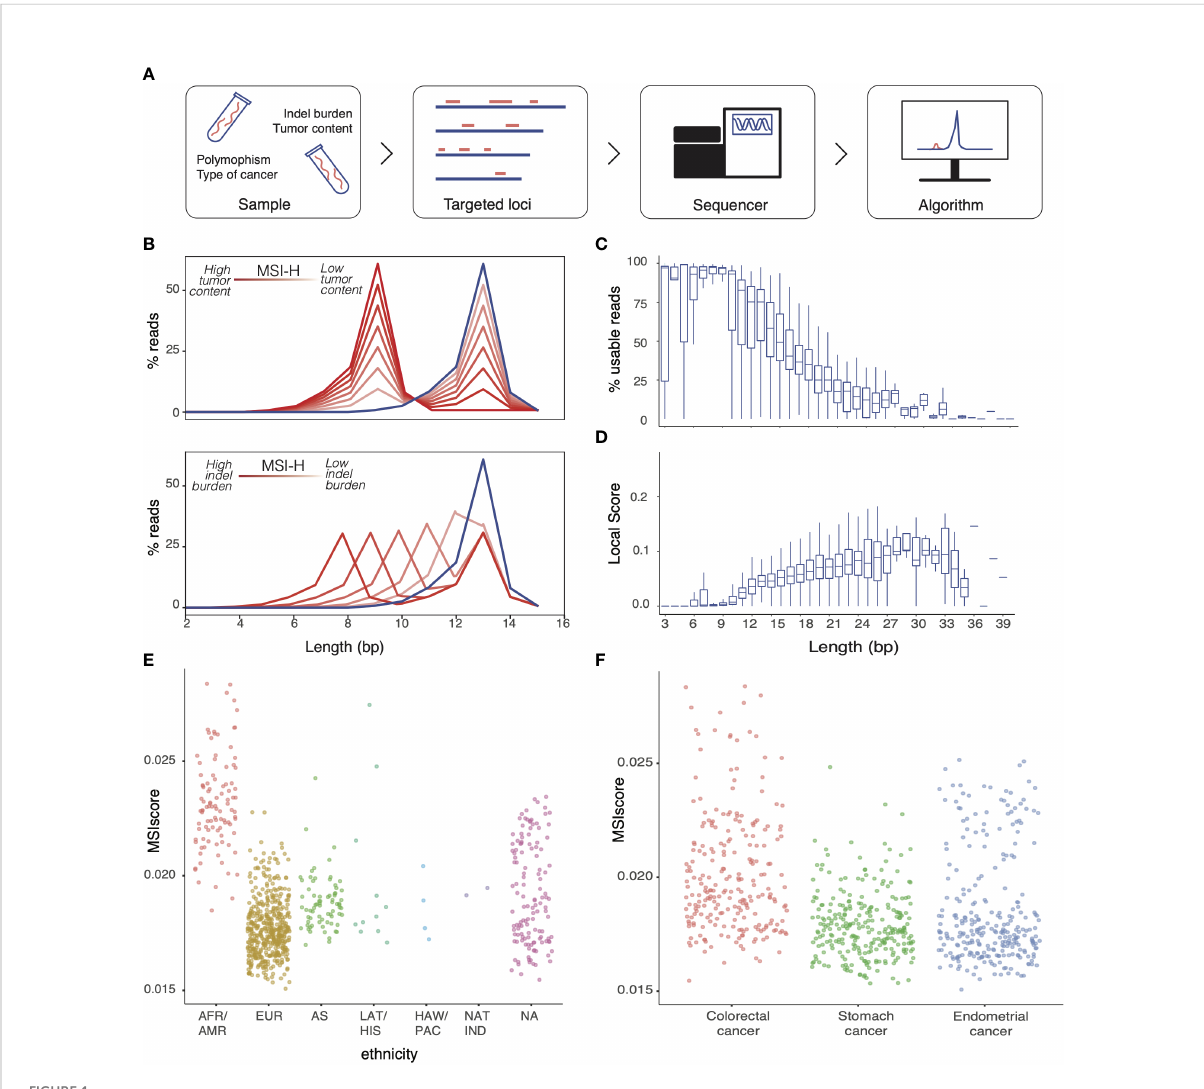
FIGURE 1 Factors limiting MSI detection in NGS work fl ow (A) Factors impacting detection of MSI in tumor-only NGS work fl ows (B) Schematic representation of the impact of increased indel burden (bottom panel) and tumor content (top panel) on the homopolymer length distribution measured by NGS at an illustrative homopolymer (MSI-H, red). Line color darkness correlates with decreased tumor content (top panel) or indel burden (bottom panel). Reference homopolymer length distribution for microsatellite stable is depicted in blue. Distribution of (C) Fraction of usable reads per total number of reads mapping to the homopolymer and (D) homopolymer score for homopolymers of the same length. MSI score obtained with MSIdetect using WES homopolymers for microsatellite stable (MSS) samples derived from (E) individuals of different